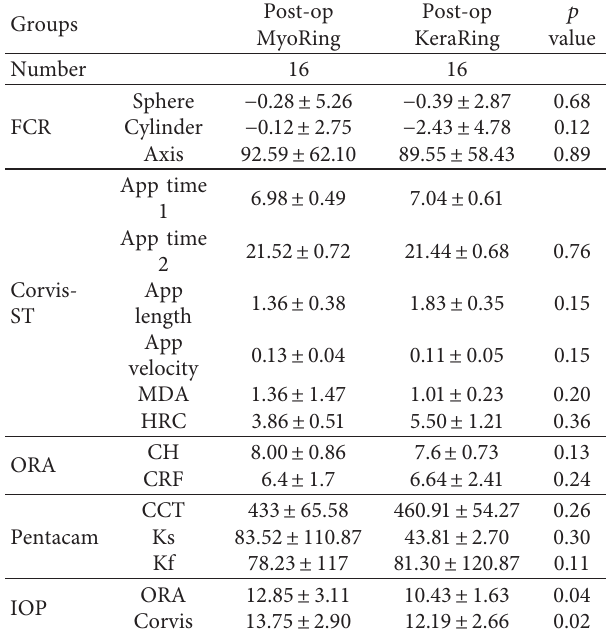
Table 4: Comparison of the results of KeraRing and MyoRing implantation in KCN patients.